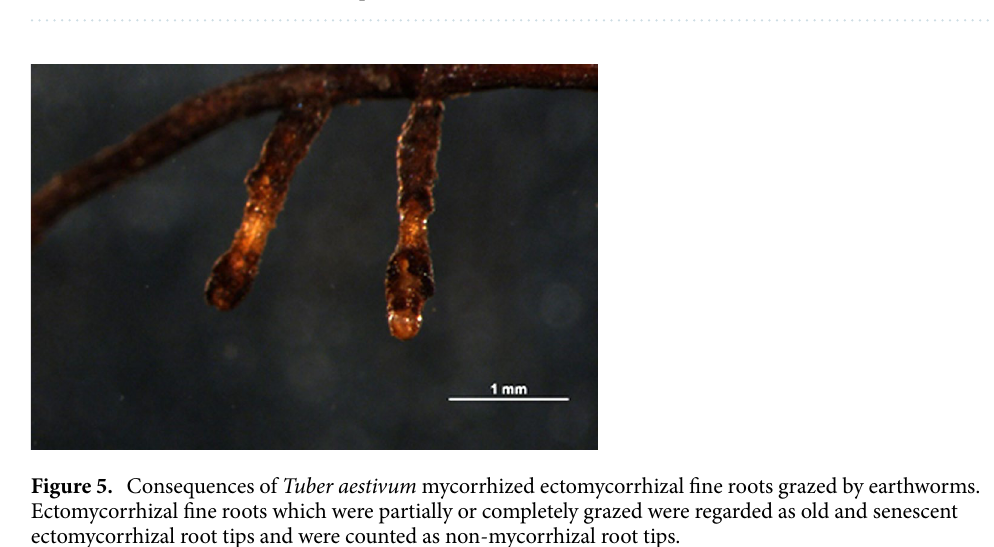
Figure 4. Mycorrhization level of Tuber aestivum inoculated seedling with and without added earthworms, after 6 months and 12 months from spore inoculation, n = 20.